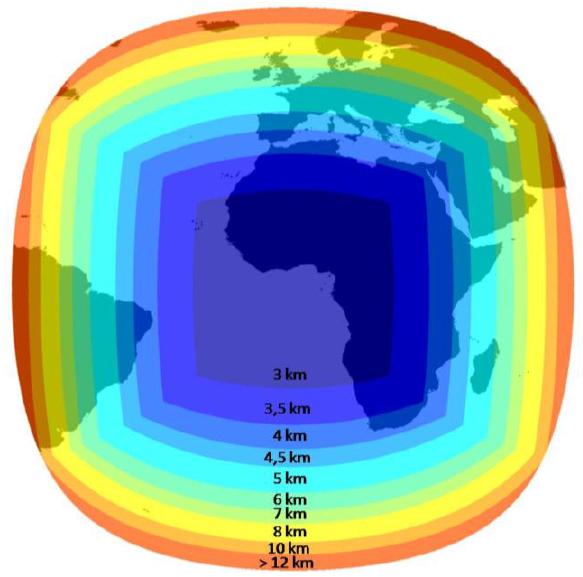
Figure 2. Spatial resolution and coverage of the SEVIRI instrument